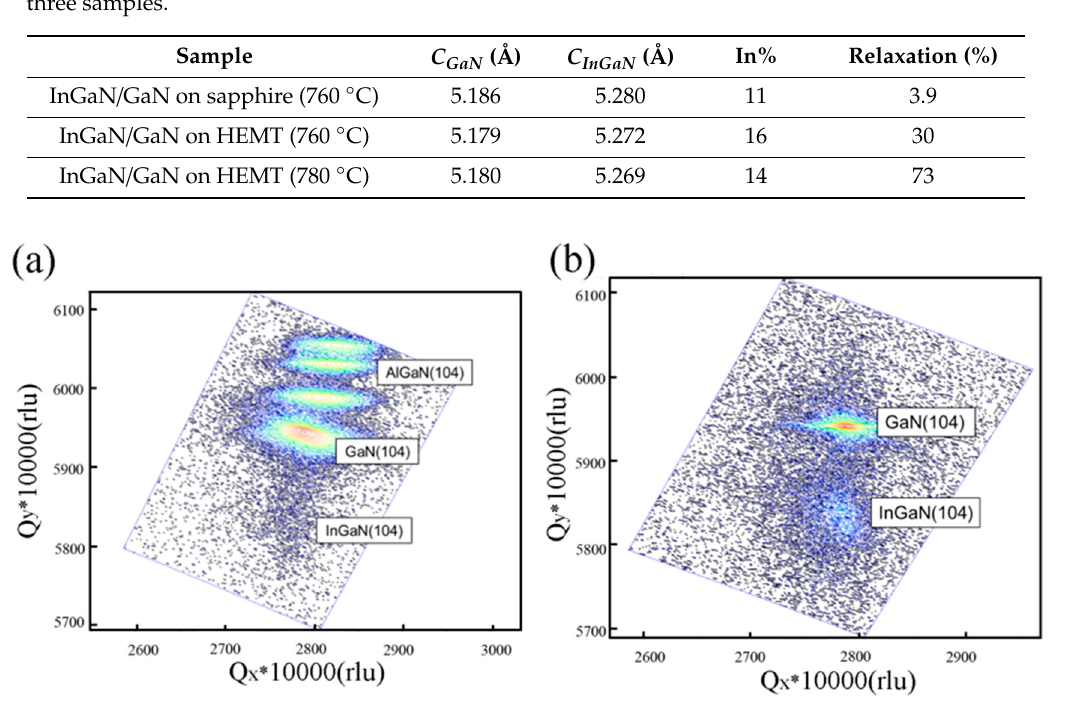
Figure 4. ( a ) XRD (002)-plane 2theta-omega scan for the InGaN/GaN heterostructure on AlGaN/GaN- on-Si HEMT at the temperature of 780 °C. ( b ) The corresponding XRD rocking curve of (002)-plane for the InGaN epitaxial layer.